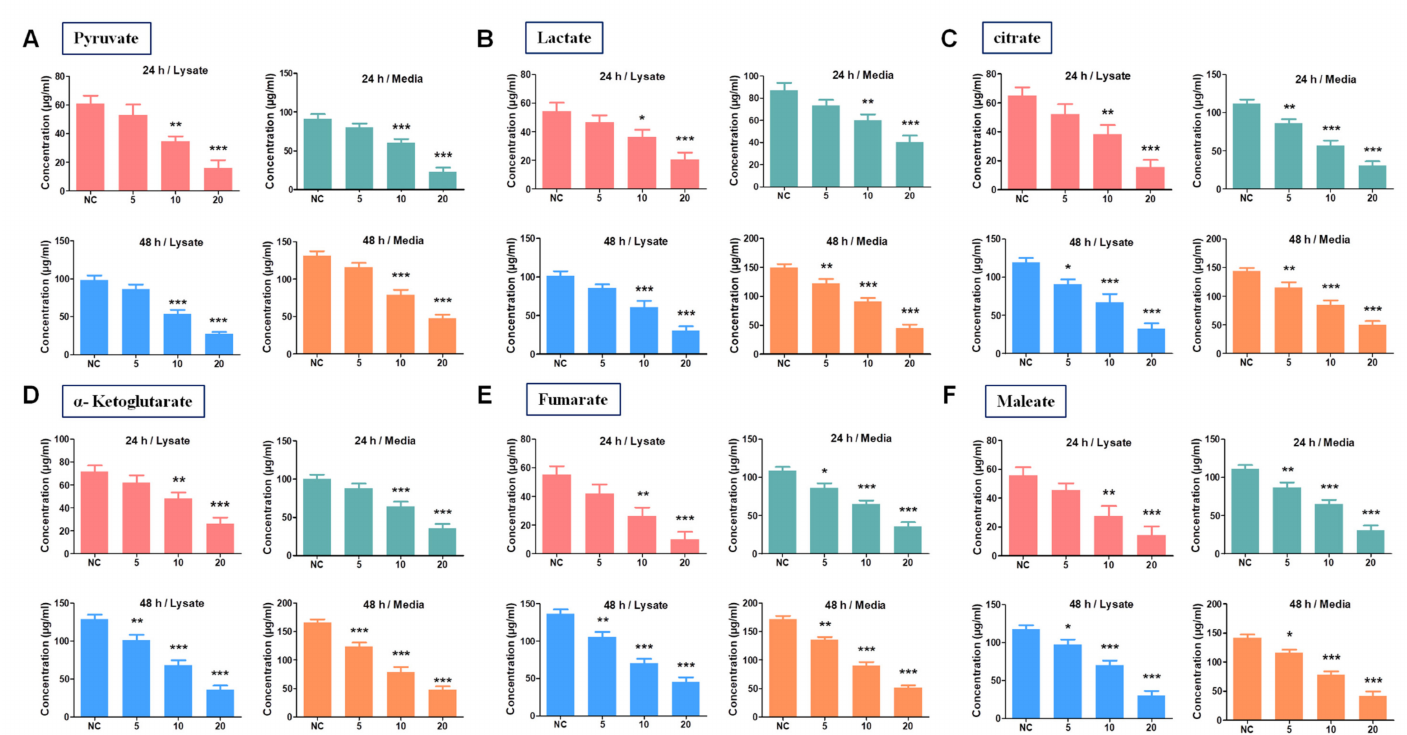
Figure 4. E ff ect of SH-859 treatment on cell metabolite level in 786-O cells after 48 h. ( A ) Quantification of pyruvate level in lysates and media. Treatment with SH-859 significantly reduced pyruvate levels in the lysate and media as compared with the normal control (untreated 786-O cells) after 48 h. ( B ) Quantification of lactate in lysates and media. SH-859 noticeably reduced the lactate level in lysates and media of 786-O cells as compared with normal control (untreated 786-O cells). ( C ) Citrate level was significantly reduced in cell lysate and media after SH-859 treatment as compared with the normal control (untreated 786-O cells). ( D ) Quantification of reduction of α -ketoglutarate concentration in the cell lysate and media was observed after SH-859 treatment, as compared with normal control (untreated 786-O cells). ( E ) Quantification of fumarate in lysates and media. SH-859 significantly reduced the concentration of fumarate in the lysate and media as compared with normal control (untreated 786-O cells). ( F ) Quantification of the level of maleate in lysates and media. SH-859 significantly reduced the concentration of maleate in the lysate and media as compared with normal control (untreated 786-O cells). Representative results from three independent experiments ( n = 3) are shown. One-way ANOVA was used to compare the means of di ff erent groups. Di ff erences between means were considered significant at p < 0.05 using Tukey’s multiple comparison test; * p < 0.05, ** p < 0.01, and *** p < 0.001 as compared with normal control (untreated 786-O